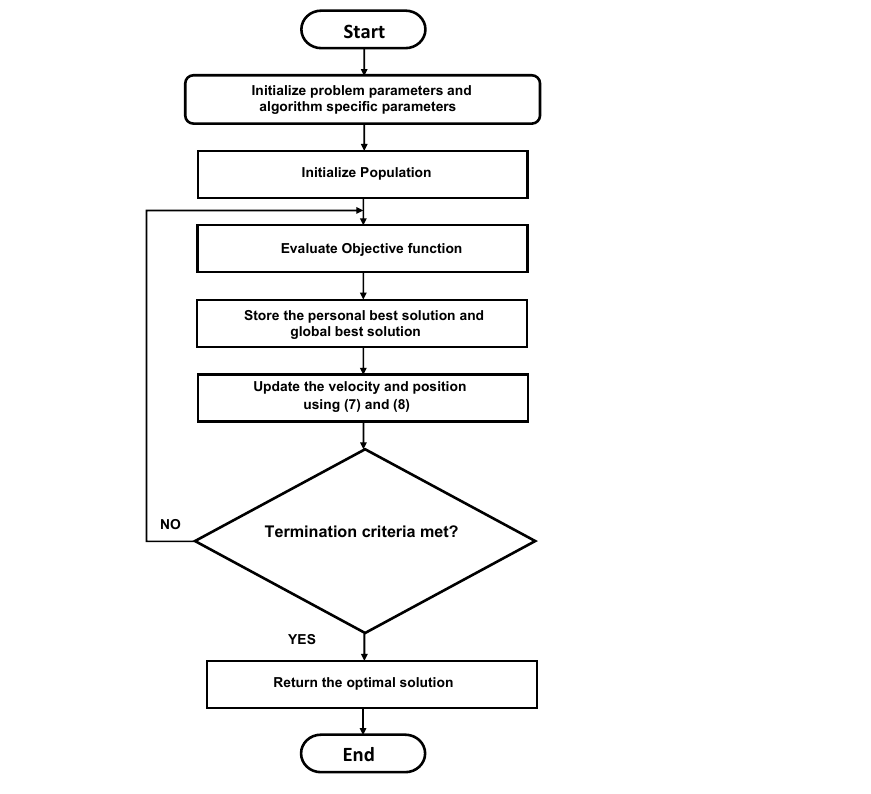
Figure 3. Flow diagram of PSO algorithm